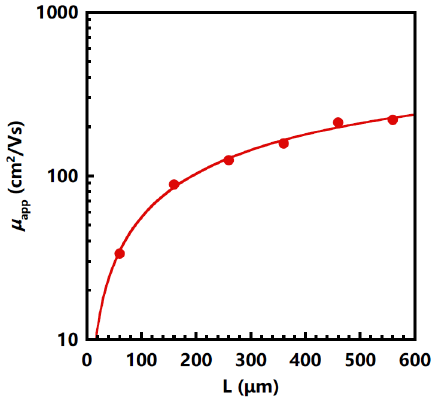
Figure 3. The extracted apparent field-effect mobility µ app as a function of channel length and the fitting result considering the contact